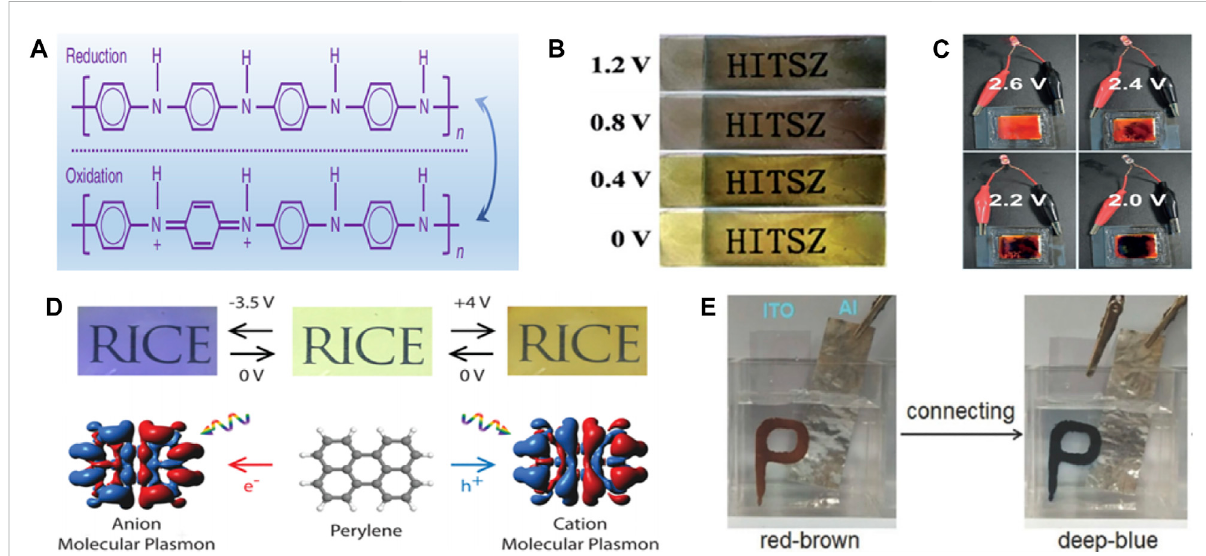
FIGURE 1 (A) chemical structures of reduced and oxidized forms of PANI. (Xu et al., 2016) with permission from Springer. (B) Photos of PPy at different voltages. (Wang et al., 2018) with permission from Royal Society of Chemistry. (C) Color change of poly (chalcogenoviologen)s when discharged from 2.6 to 2.0 V. (Li et al., 2019d) with permission from Wiley-VCH. (D) The PAHs-based material enables reversible switching of multiple colors when applied voltages of -3.5, 0, and +4 V. (Stec et al., 2017) with permission from American Chemical Society. (E) Photo of NA/H 6 P 2 W 18 O 62